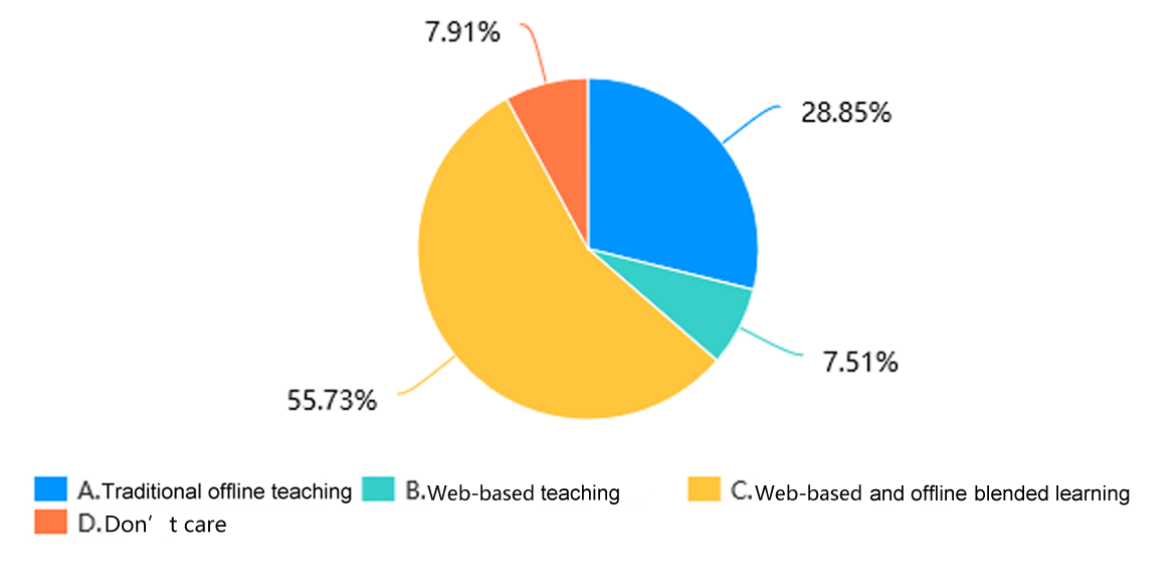
Figure 9. The proportions of students who would choose different teaching methods of histology and embryology in the future in the control group.